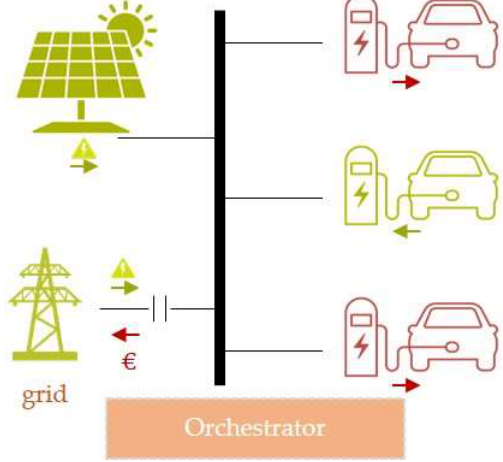
Figure 9. High-level overview of an EV charging system, where RES are integrated with the con- ventional power grid.